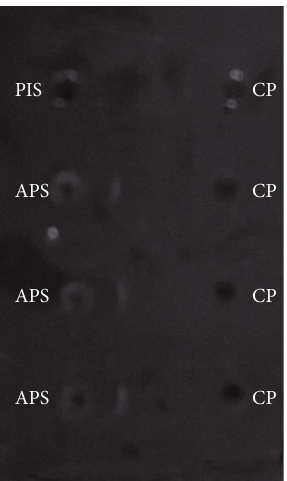
Figure 2: Ouchterlony’s double immunodiffusion. PIS: preimmune serum; APS: antiprotein serum (Anticysteine protease serum); and CP: cysteine